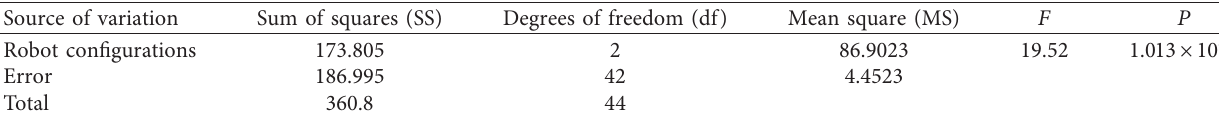
Figure 6: (a) Mean variation of uncovered area of P-hTetro (i.e., L ) and hTetro with fixed sizes of L L and L U . The error bars represent the opt standard error of mean. (b) Comparison intervals of Tukey’s honest significant difference criterion. It is considered that there is no significant difference between the means of corresponding groups if intervals of two groups overlap. Table 2: Results of the ANOVA test on the uncovered